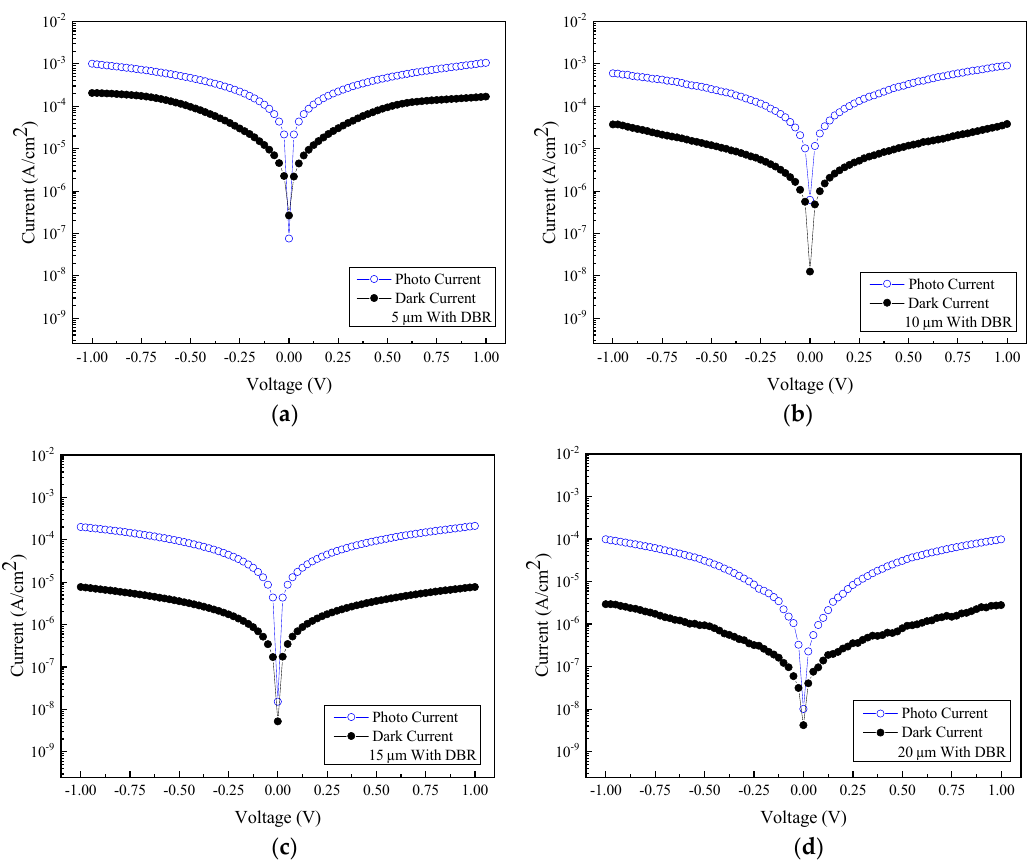
Figure 9. The photocurrent density of PDs with electrodes of different sizes (5 µm, 10 µm, 15 µm, and 20 µm) and with DBR structures coated.